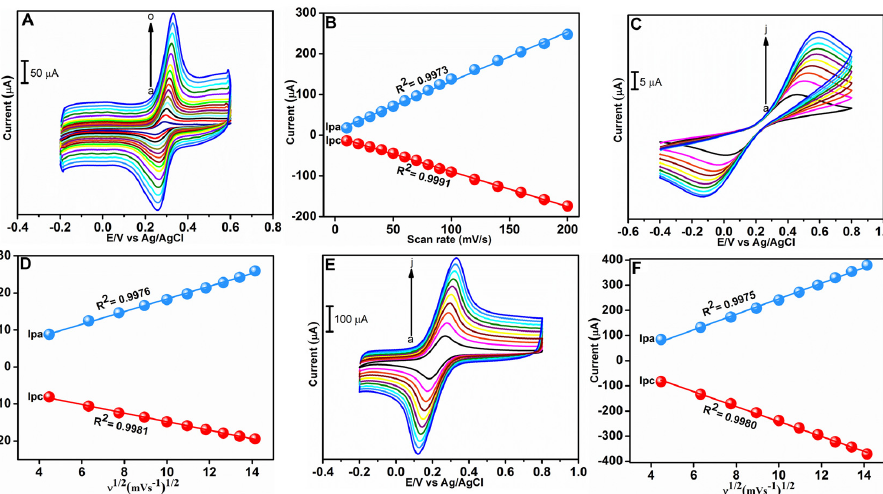
Figure 6. ( A ) CV curves of AgCuO NPs/fCNTs/SPCE at different scan rates from 0.01–0.2 V/s (a–o). ( B ) Anodic ( I pa ) and cathodic ( I pc ) peak currents against scan rate. Voltametric response in ferricyanide system for various scan rates from 0.02–0.2 V/s (a–j) at ( C ) bare SPCE and ( E ) AgCuO NPs/fCNTs/SPCE. Redox peak current vs. square root of scan rate at ( D ) bare SPCE and ( F ) AgCuO NPs/fCNTs/SPCE.